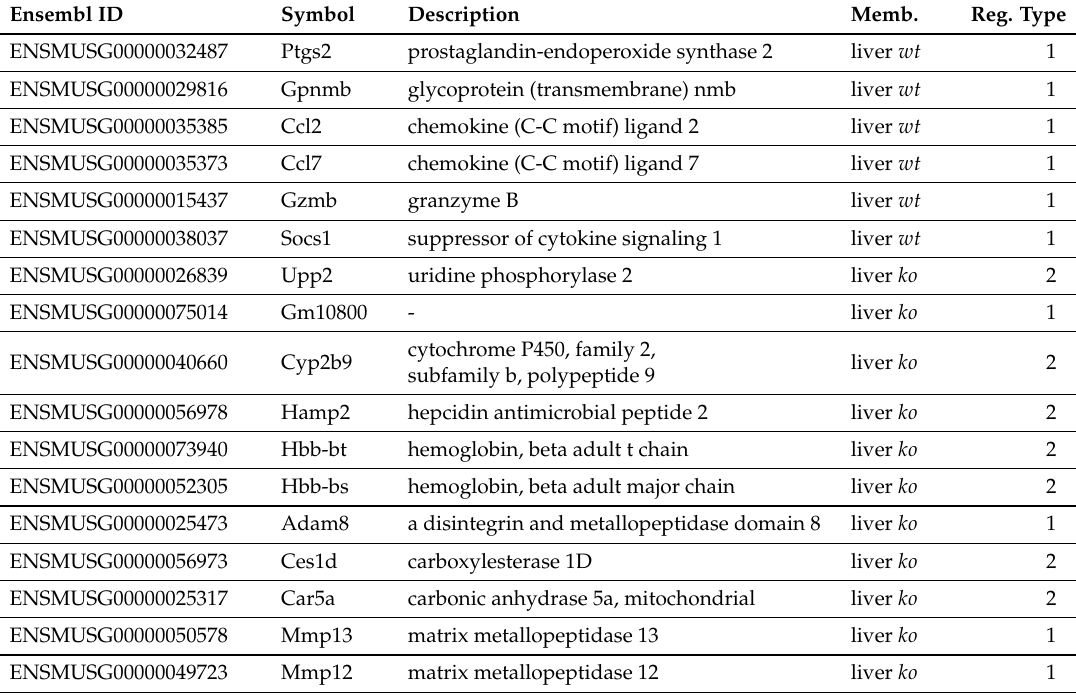
Table A6. Highly DEG. List of DEG that are differentially-expressed for every of the comparisons performed: control vs. cases at 3 d p.i., control vs. cases at 5 d p.i. and cases at 3 vs. 5 d p.i. Memb, membership to the group of samples genes belong; ko , Ly6E ∆ HSC samples. Reg. Type refers to the three expression patterns observed, described in Section